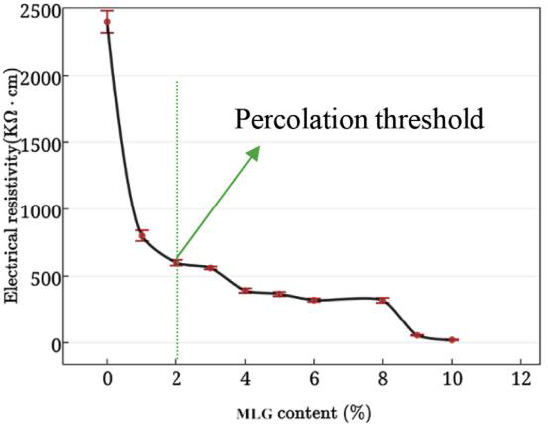
Figure 21. Electrical resistivity of graphene/cement composites. Reprinted with permission from Ref. [46]. Copyright 2017 Elsevier.